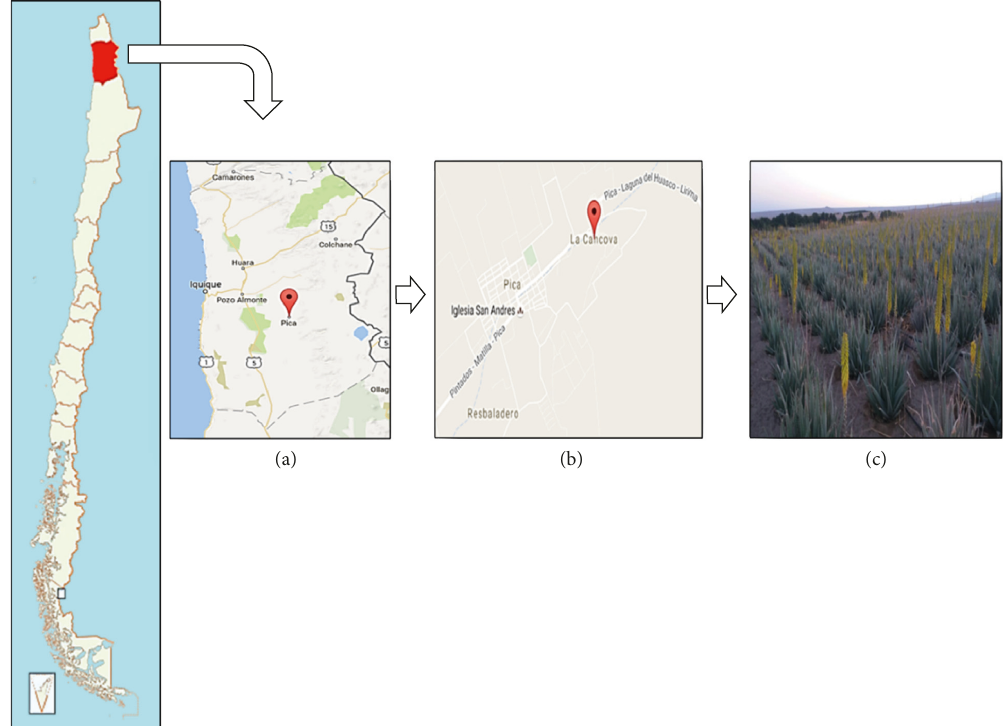
Figure 1: Map of Chile showing the location of Tarapaca Region: commune of Pica (a), La Concova sector (b), and the A. vera crops